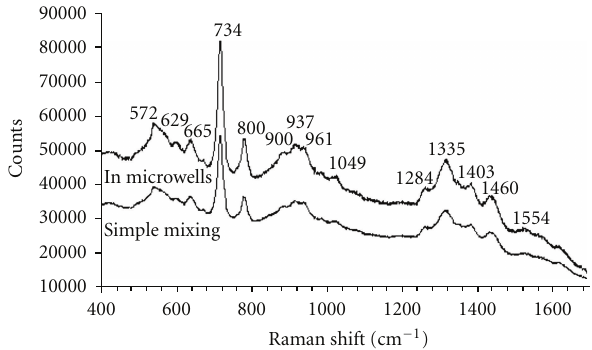
Figure 6: Comparison of SERS spectra of S. cohnii obtained in microwells and with simple mixing.